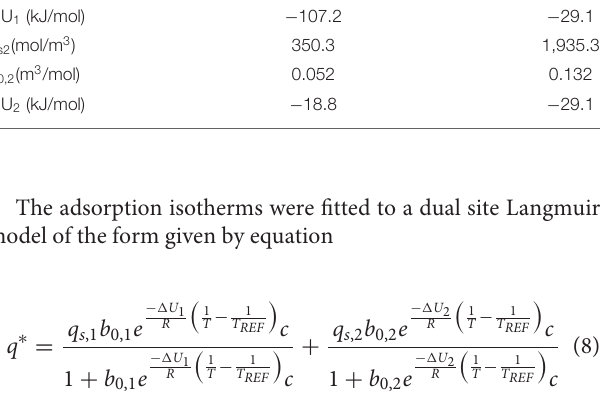
signal. The maximum values were 1.0 × 10 − 7 and 1.5 × 10 −